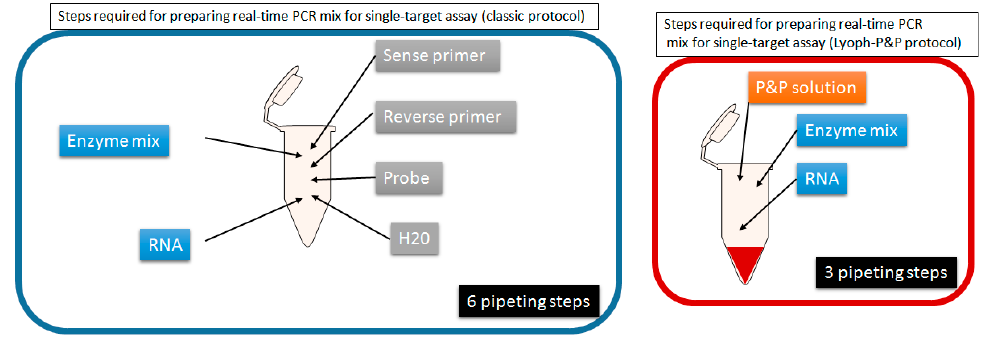
Figure 1. Schematic representation of the two formulas tested in this study. Viruses 2019 , 11 , x FOR PEER REVIEW